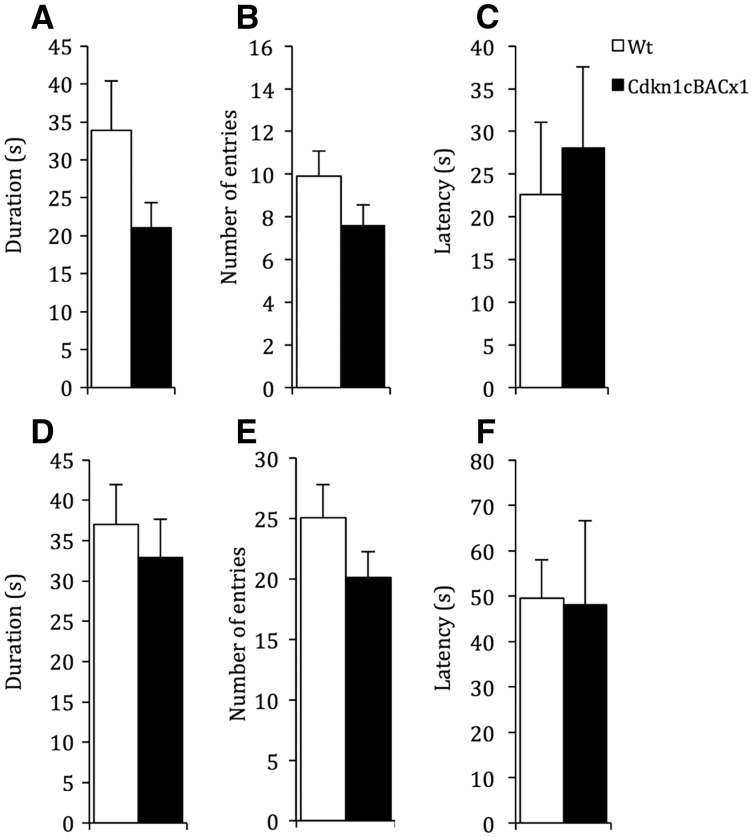
Emotional reactivity was intact in Cdkn1cBACx1 animals. There were no differences between Cdkn1cBACx1 animals and their WT littermates in measures on the EPM test, including (A) time spent on open arm, (B) entries into open arm and (C) latency to first enter open arm. Similarly, there were no differences between Cdkn1cBACx1 animals and their WT littermates in measures on the OF test, including (D) time spent in centre zone, (E) entries into centre zone, and (F) latency to first enter centre zone. Data shown is ± SEM.